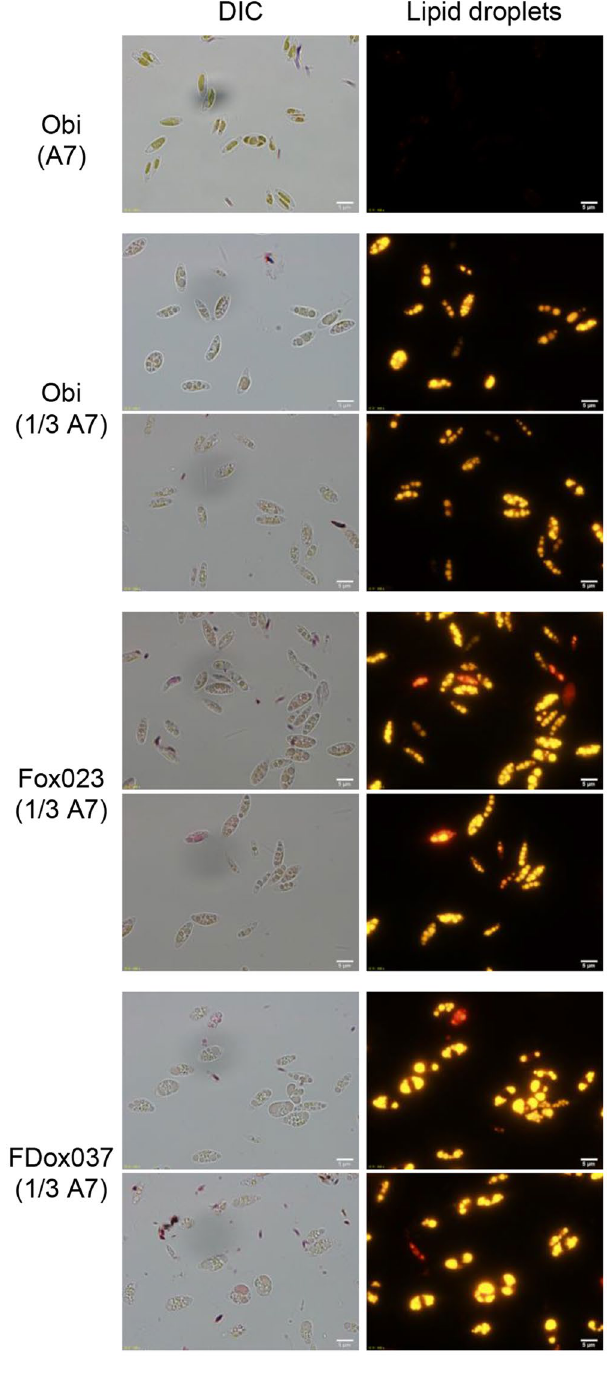
Figure 3. Accumulation of intracellular lipid droplets in transgenic Coccomyxa strains. Left panel, differential interference contrast (DIC) microscopy of cells; right panel, fluorescence microscopy of Nile Red-stained lipid droplets. All images were acquired with a fluorescent microscope (BX51, Olympus). The scale bar represents 5 μ m. Cells were grown for 14 days in either A7 or 1/3 A7